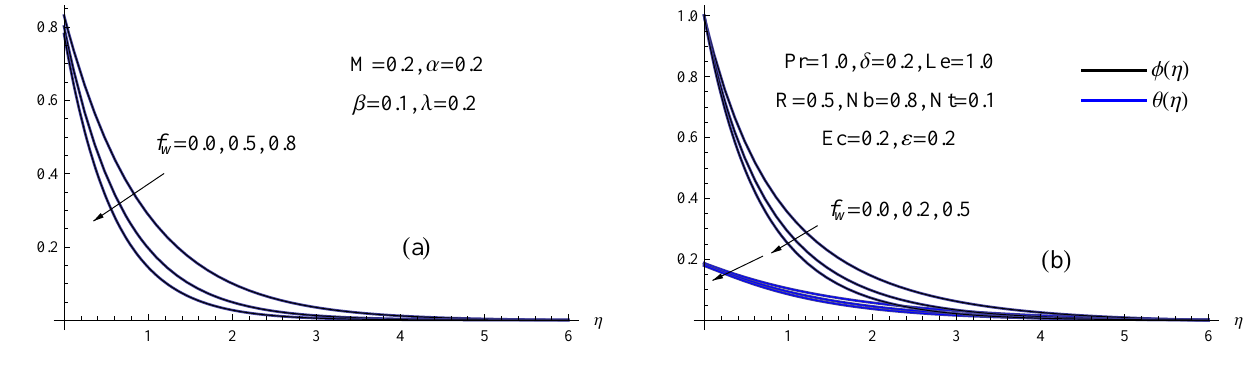
0.20.40.60.81.0